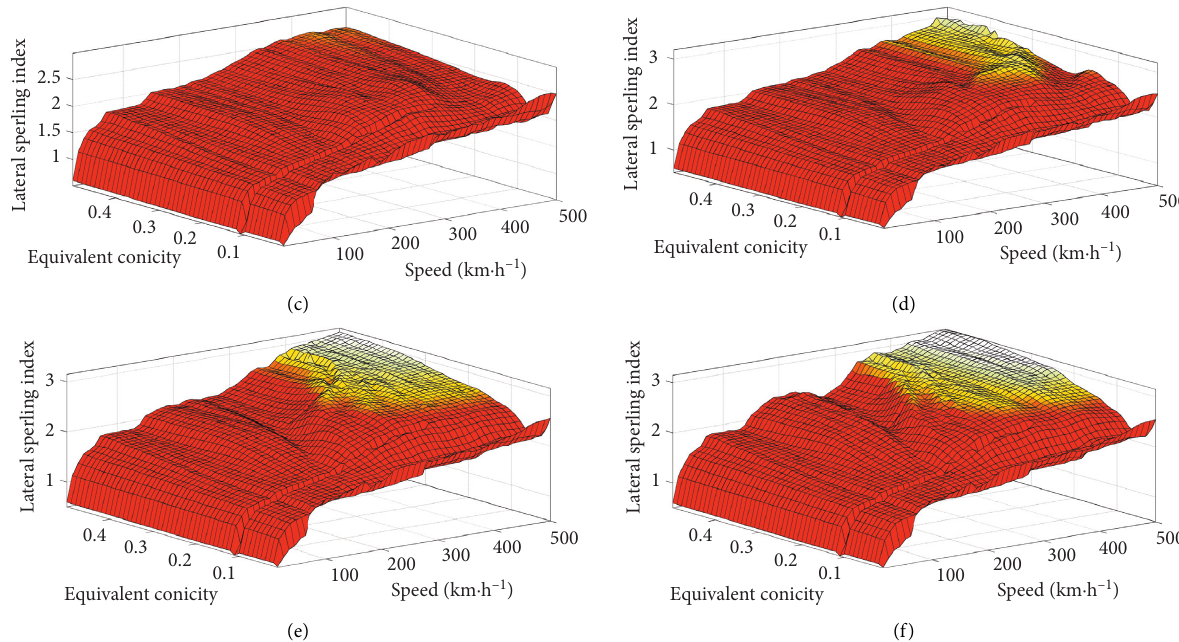
Figure 16: Vehicle ride quality space with joint stiffness of 25MN · m − 1 and additional stiffness of 4 MN · m − 1 . (a) c � 0. (b) c � 110kN · s · m − 1